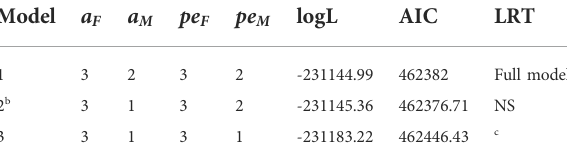
TABLE 3 Summary of the fi tted degree of Legendre polynomials a used in the random regression model with their corresponding log likelihoods (logL), Akaike information criteria (AIC), and the signi fi cance of their log likelihood ratio test (LRT) relative to the full